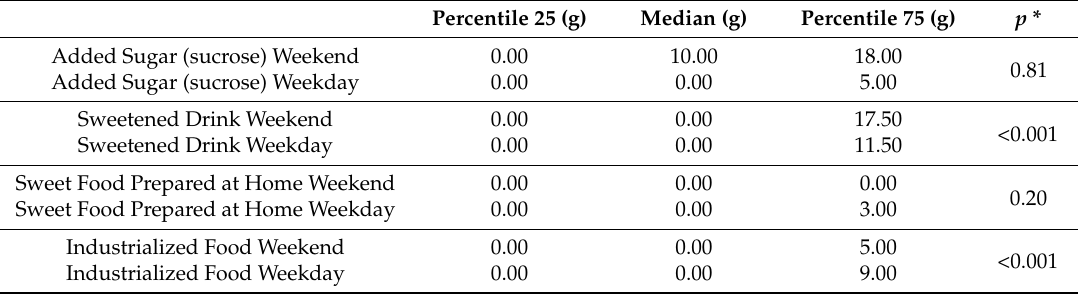
Table 2. Central tendency measure and variance of sugar (sucrose) consumption (g) of the low-income population in Brazil when comparing weekend and weekdays ( n =